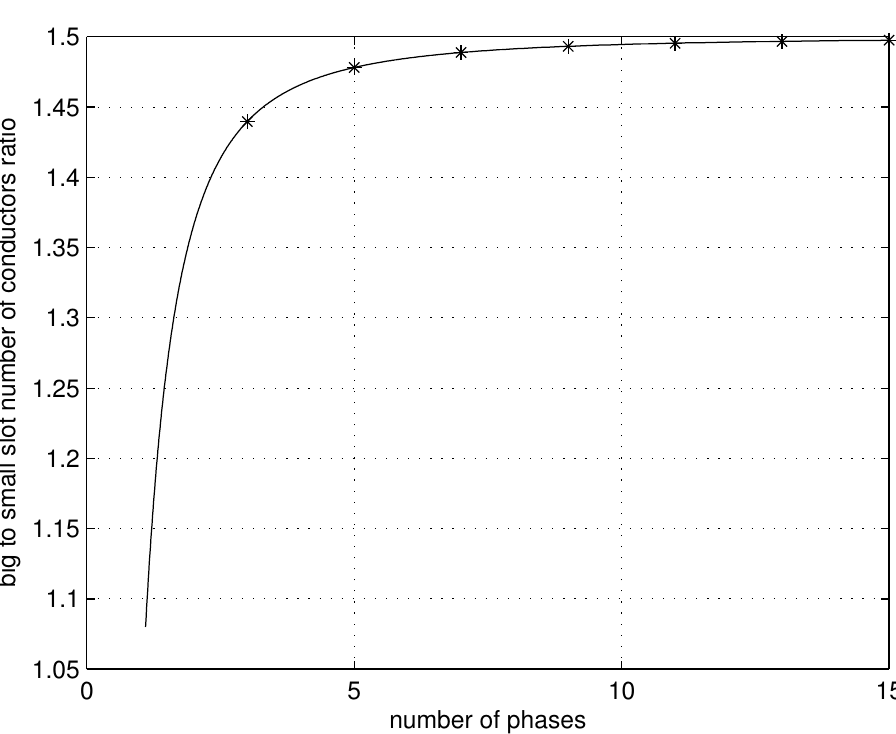
N H + N L versus the number of phases q 2 N L